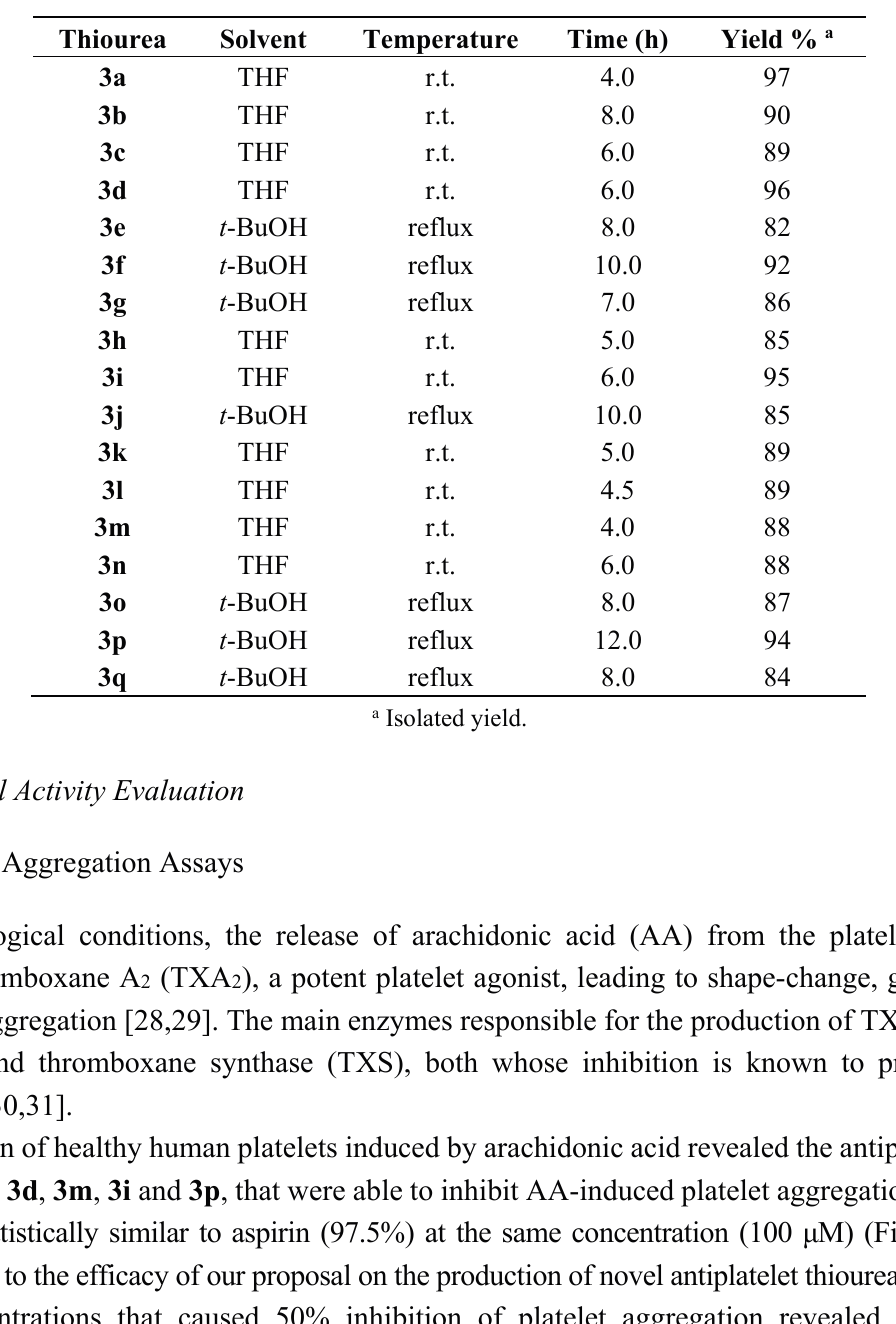
Table 1. Reaction conditions and yields for thioureas 3a – q produced using Scheme